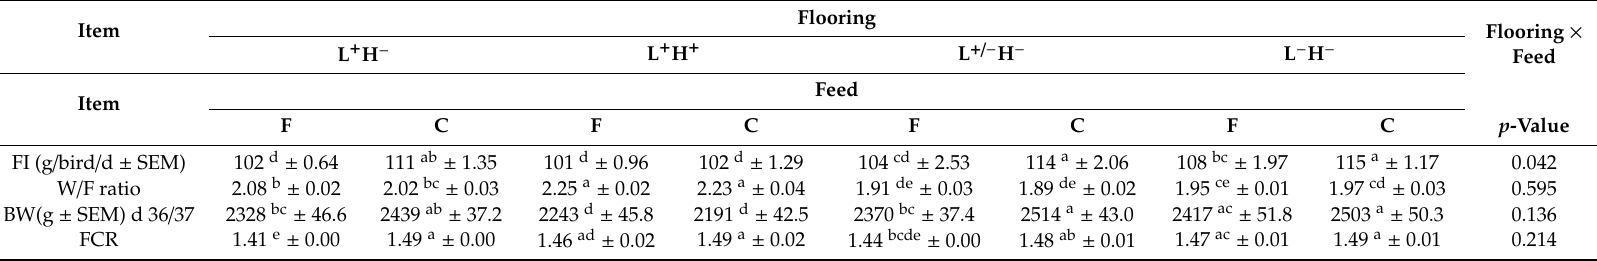
Table 7. Performance indices of broilers fed di ff erent feed particle sizes and reared on di ff erent floor designs (flooring × feed) from d 8 to d 36 / 37.